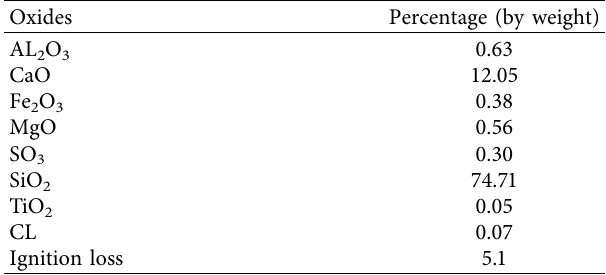
Table 4: Chemical analysis of lightweight porcelinite aggregate ∗ .